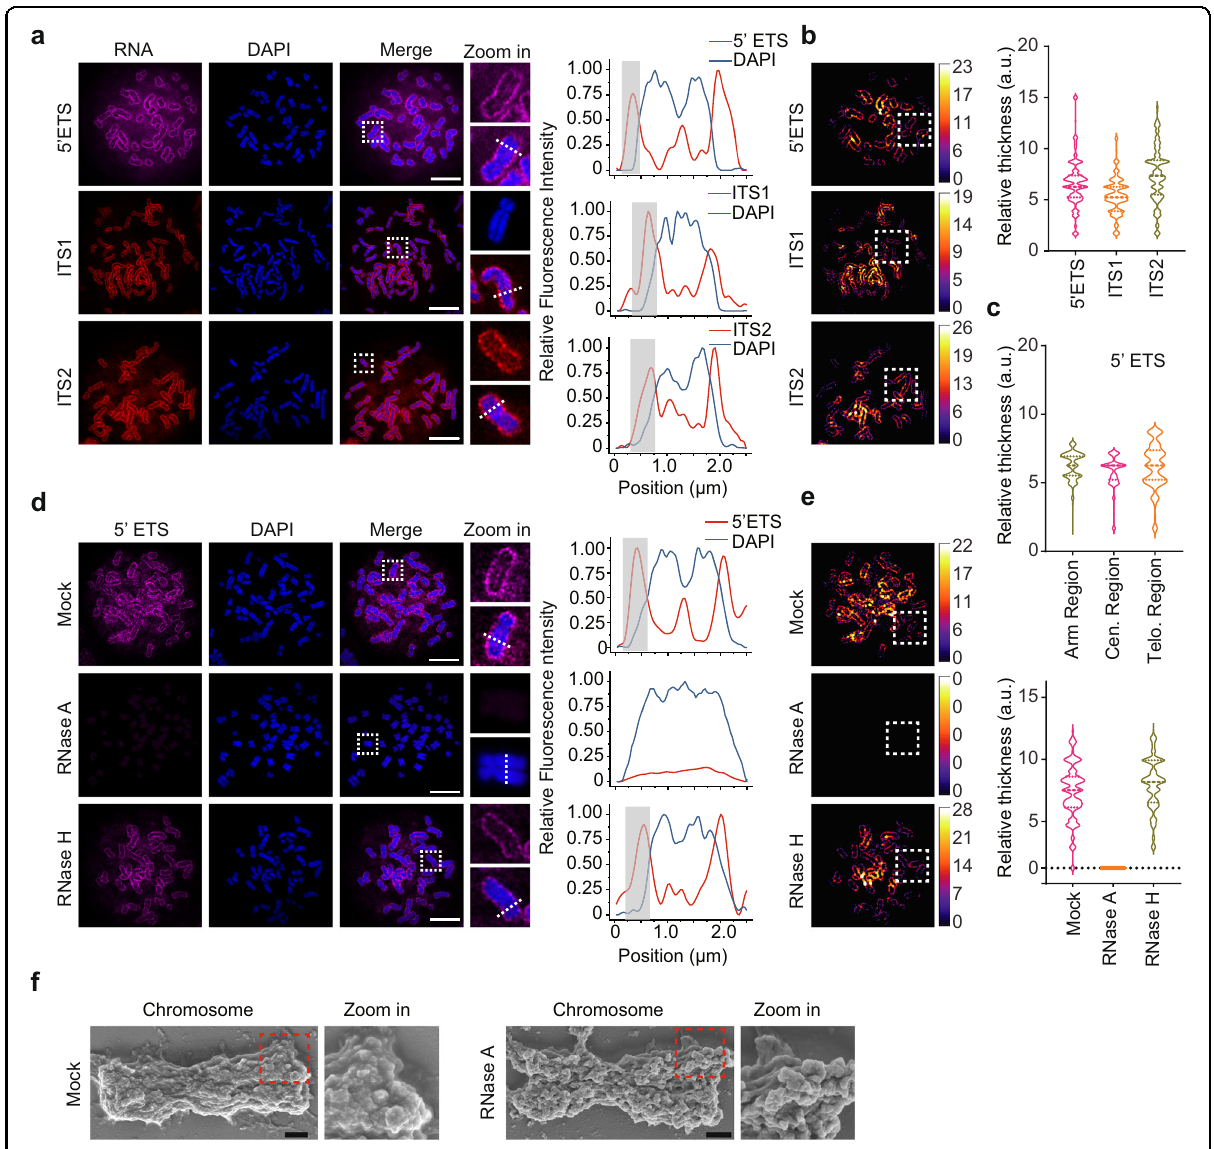
Fig. 2 pre-rRNA localizes at the periphery of mitotic chromosomes. a Localization of 45S (5 ’ ETS), 30S (ITS1), and 32S (ITS2) pre-rRNAs at the perichromosomal layer. The RNA species were examined by RNA FISH with Cy5-labeled probe against 5 ’ ETS, Cy3-labeled probes against ITS1 and ITS2 regions of pre-rRNAs in mitotic spreads. Chromosomes were counterstained with DAPI. Representative images are shown (left panel). The fl uorescence signals on the white dash lines were examined (right panel), gray shadows indicate the perichromosomal layer of 45S, 30S, and 32S pre-rRNAs. Scale bar, 10 μ m. b RNA is extended from the condensed chromosomes. The RNA FISH signal was analyzed by “ Local Thickness ” of Fiji to calculate the average RNA extension distance on the periphery of chromosomes, the dashed squares show the region of interest with isolated single chromosome. c The extension of 45S pre-rRNA on the periphery of different regions of each chromosome. d RNase A treatment abolishes the RNA species at the periphery. The mitotic spreads were treated with or without RNase A or RNase H. The fl uorescence intensity of 45S rRNA was measured at the indicated section with white lines, gray shadow shows the perichromosomal layer of 45S pre-rRNA (right panel). Scale bar, 10 μ m. e The RNA FISH signal was analyzed by “ Local Thickness ” of Fiji to calculate the average thickness of the 45S pre-rRNA coated at the periphery of chromosomes. Violin plots show the extension of RNA at the periphery. f SEM shows the detailed structure of chromosome treated with or without RNase A. Scale bar,